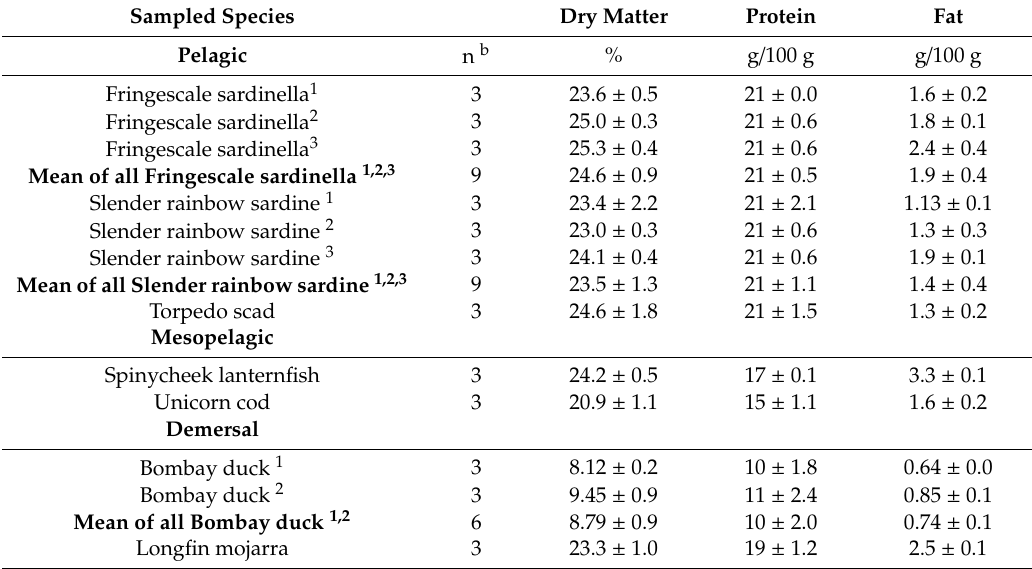
Table 3. Analytical values of the proximate composition of the fish species sampled from Bangladesh a